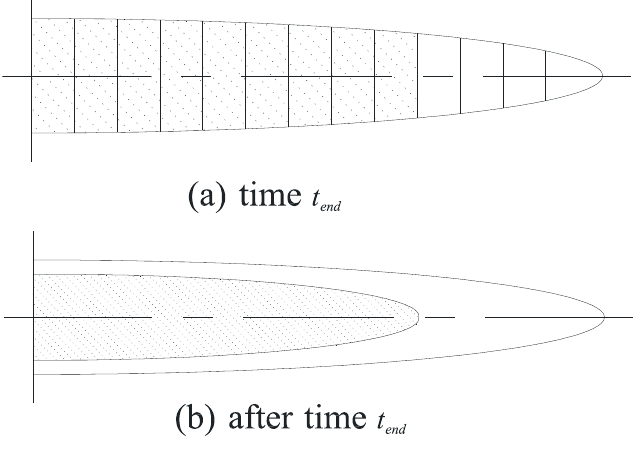
Figure 2. Schematic diagram of fracture closure.